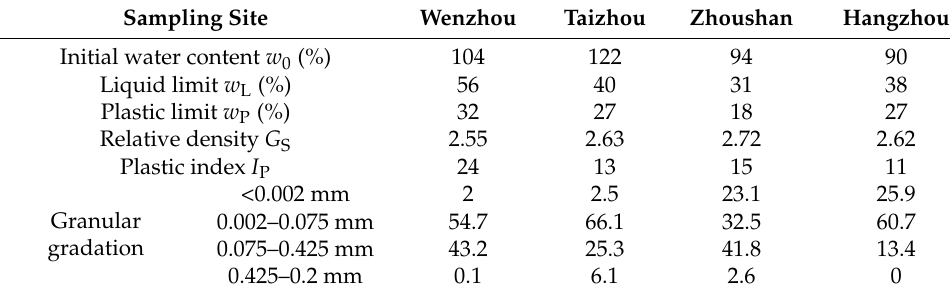
Table 1. Basic physical properties of the four types of soil samples.